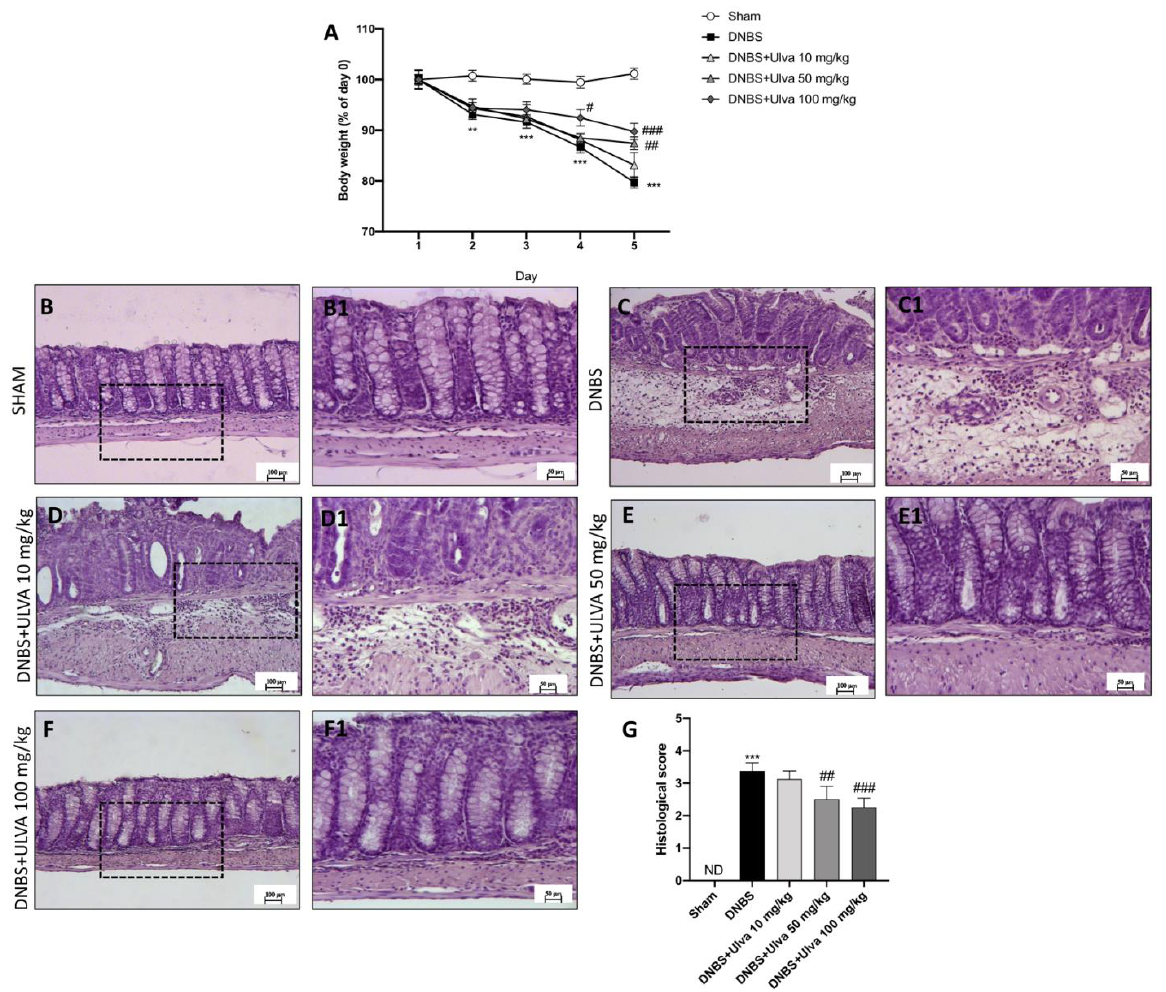
Figure 1. Effects of Ulva pertusa on body weight and histological damage. A decrease in body weight was observed in mice of the DNBS group compared to sham animals ( A ). Only Ulva at doses of 50 mg/kg and 100 mg/kg significantly reduced weight loss ( A ). Four days after DNBS intrarectal injection mice showed a marked alteration of tissue morphology ( C ), 20 × magnification ( C1 ), score ( G ), compared to the control group ( B ), 20 × magnification ( B1 ), score ( G ). Treatment with Ulva at the highest doses restored colon architecture ( E ), 20 × magnification ( E1 ) and ( F ), 20 × magnification ( F1 ), score ( G ), unlike treatment with the lowest dose which did not exert beneficial effects ( D ), 20 × magnification ( D1 ), score ( G ). Data are representative of at least three independent experiments. Values are means ± SD. One-way ANOVA test followed by Bonferroni. One-way and two-way ANOVA test. ** 0.01 vs. Sham; *** p < 0.001 vs. Sham; # p < 0.05 vs. DNBS; ## p < 0.01 vs. DNBS; ### p < 0.001 vs. DNBS; ND: not